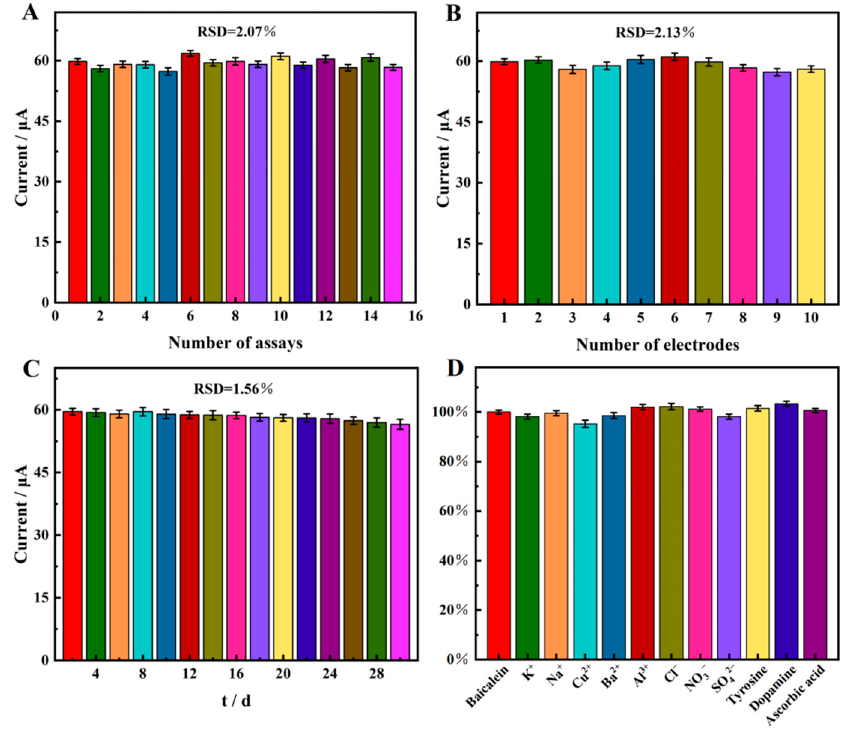
Figure 9. ( A ) Repetitive DPV responses of TiO 2 -MXene/PEDOT:PSS/GCE with the same electrode; ( B ) DPV responses of TiO 2 -MXene/PEDOT:PSS/GCE for ten parallel electrodes; ( C ) DPV responses of TiO 2 -MXene/PEDOT:PSS/GCE toward 10.0 µM baicalein in one month; ( D ) Selectivity studies of TiO 2 -MXene/PEDOT:PSS/GCE.